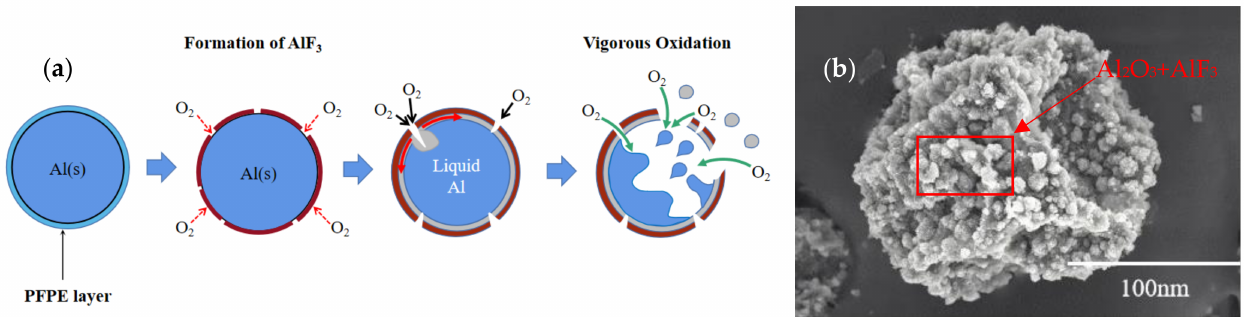
Figure 7. ( a ) Schematic description of oxidation mechanism of PFPE-functionalized Al NPs and ( b ) enlarged SEM image of the oxidized PFPE-functionalized Al